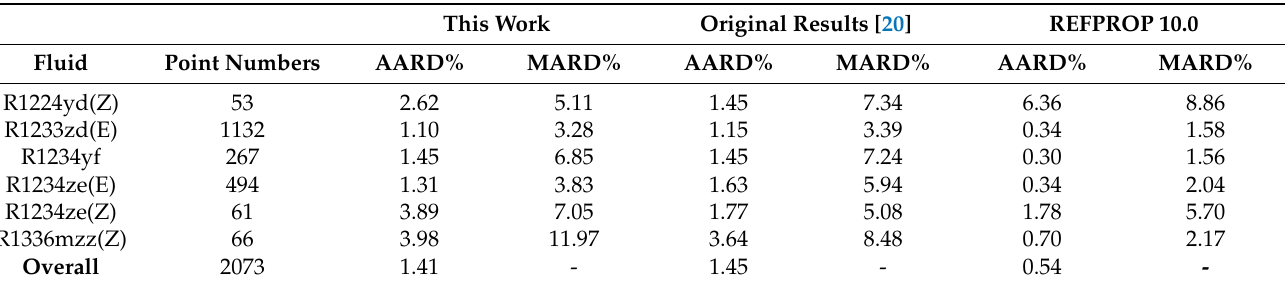
Table 4. Deviations between the experimental liquid thermal conductivity data of the low-GWP refrigerants and the results provided by Equation (1) with the new coefficients calculated using NSGAII, the original results of Equation (1) [20], and REFPROP 10.0